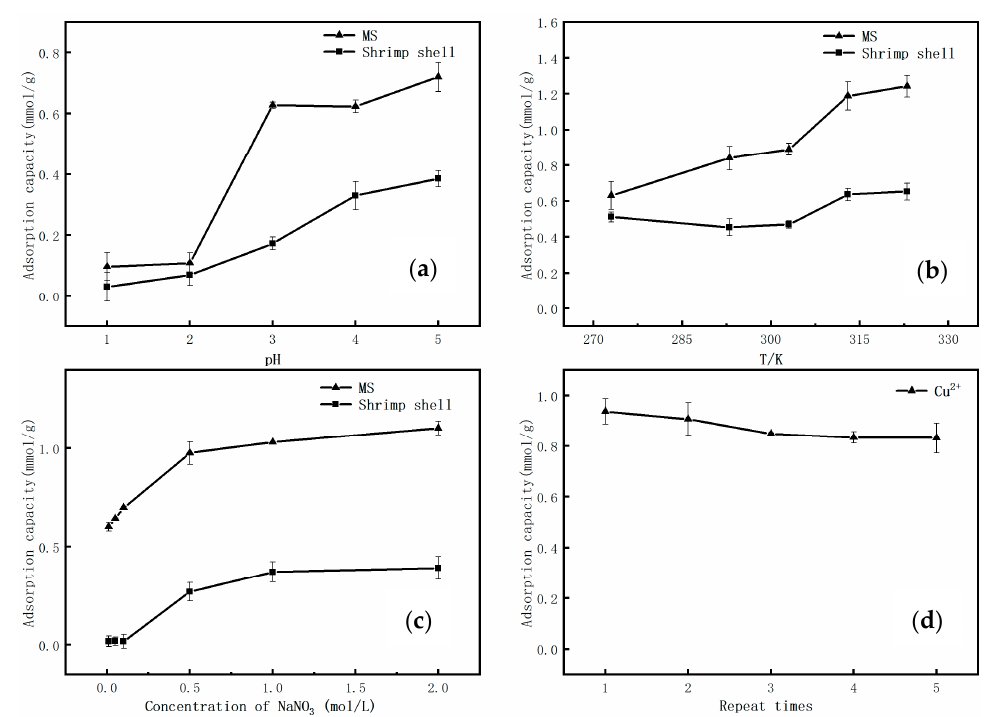
Figure 3. The effect of ( a ) pH (1–5); ( b ) temperature (273 K, 293 K, 303 K, 313 K and 323 K); ( c ) ionic strength (NO 3 − ); and ( d ) 5-cycle times of 1% NaOH on the adsorption of Cu (II) by the MS.